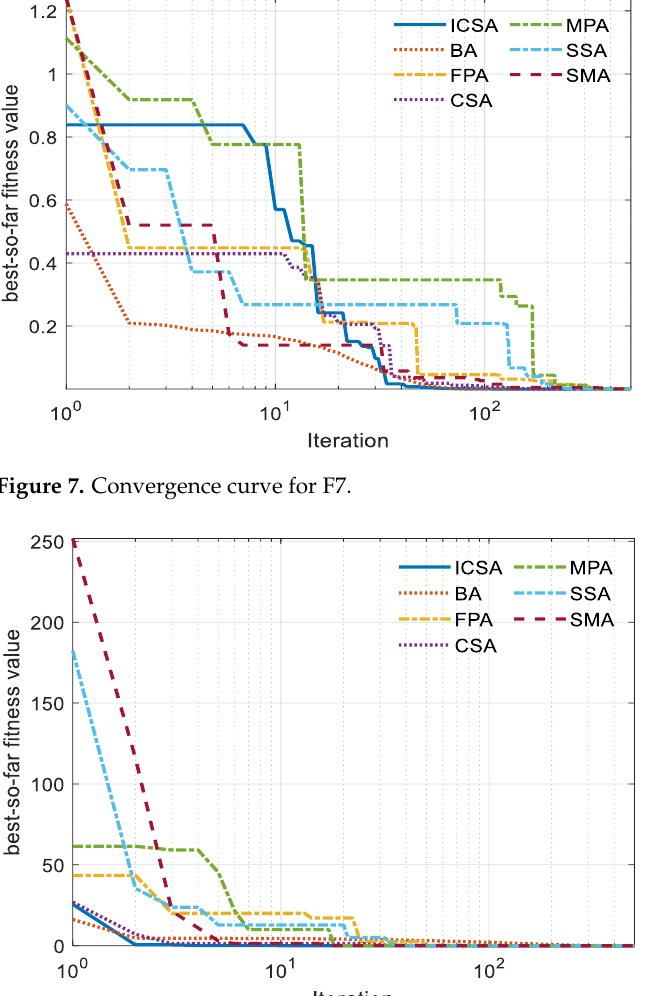
Figure 8. Convergence curve for F8.